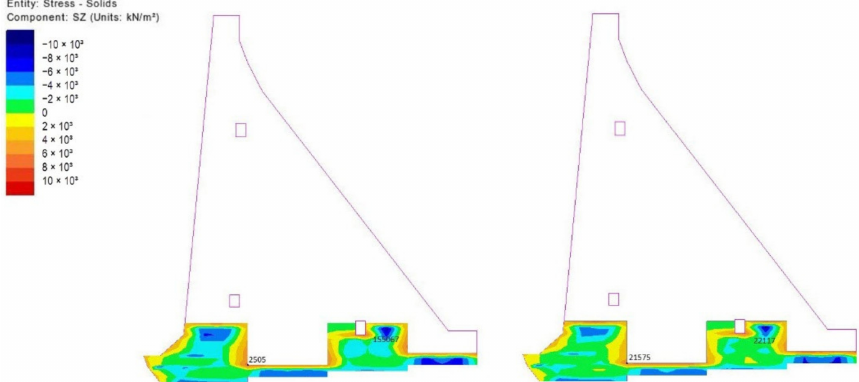
Figure 19. Stresses σ z in the mid-plane of the monolith 20 m long ( left ) and 15 m long ( right ) for the 84th day (10th of January of the second year); extremums: nodes 2505 and 21,575.